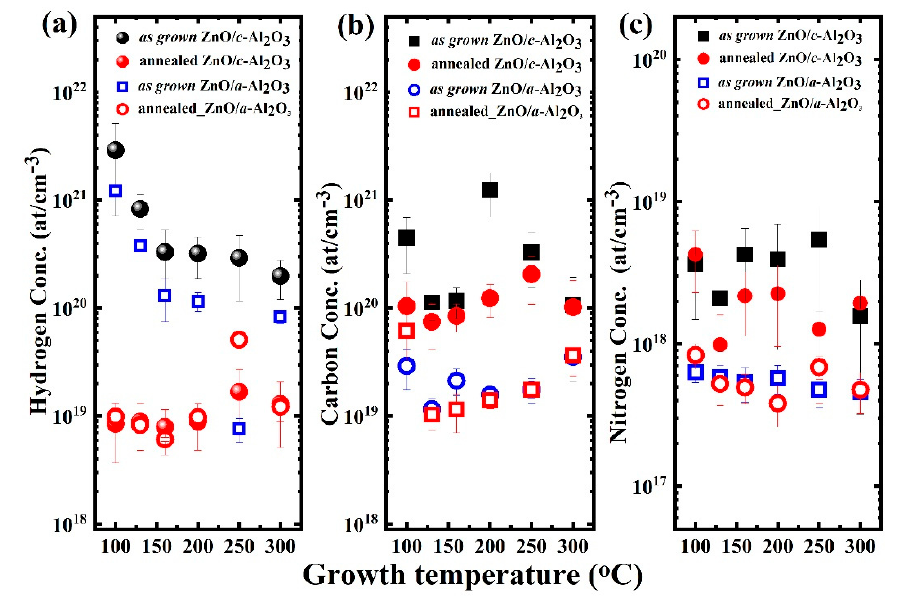
Figure 5. Impurities concentration incorporation: ( a ) hydrogen, ( b ) carbon, and ( c ) nitrogen, with successive growth temperatures T g for as-grown and annealed on ZnO/ a -Al 2 O 3 and ZnO/ c -Al 2 O 3 films. (Vertical lines show measurement uncertainty)